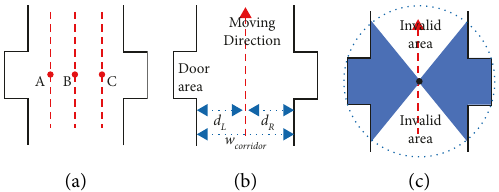
Figure 2: Mobile robot passes through the doorway area. (a) Different routes; (b) annotation data; (c) valid and invalid laser scanning routes indicated by red dotted lines are shown in Figure 2(a), and three positions are indicated by red points. There are only a few matched pairs between the visual features extracted from the image captured in position A and those in position C. Besides, the cameras oriented to different directions also have different matching results, even if in the same position.